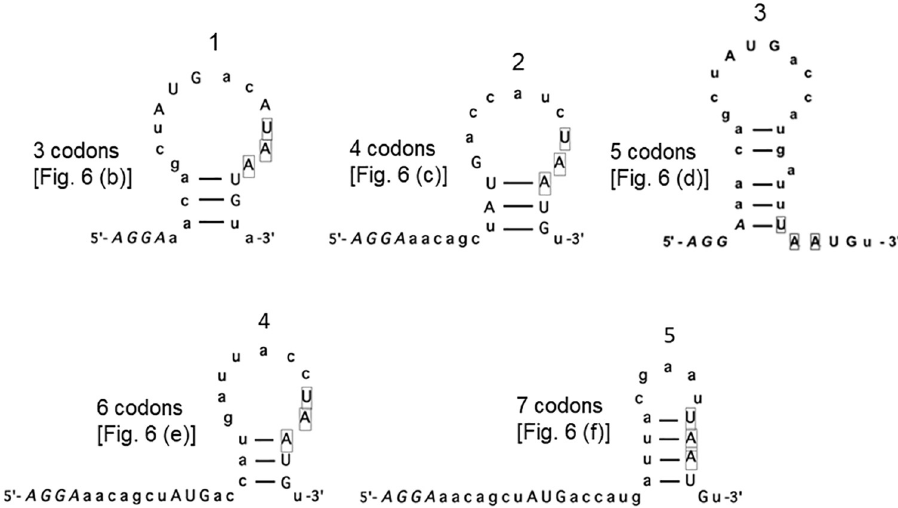
Fig 14. Possible mRNA secondary structures around the junction sequence at the non-permissive temperature of tsRRF. Stem and loop structures were constructed according to Freier et al . [56]. The SD sequence (5’- AGGA -3’), initiation and termination codons are represented by capital letters. Termination codons of u-ORF are boxed for clarity. Bars between nucleotides represent Watson-Crick type base-pairing.